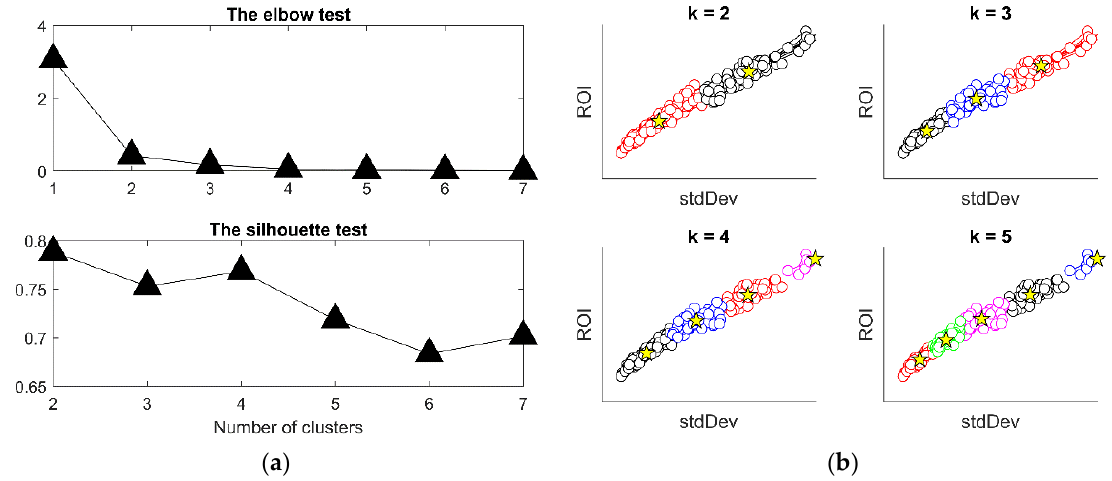
Figure 4. Quantitative ( a ) and qualitative test ( b ) for the k-means clustering Figure 5 demonstrates the classified offshore wind assets on a risk − return diagram, where the mean value of return denotes return on investment, and the standard devia- tion indicates the risk. Four groups are identified as Group A, B, C and D. Asset class D is associated with the highest expected return and the highest risk. In contrast, asset class A is associated with the lowest risk and lowest expected return.